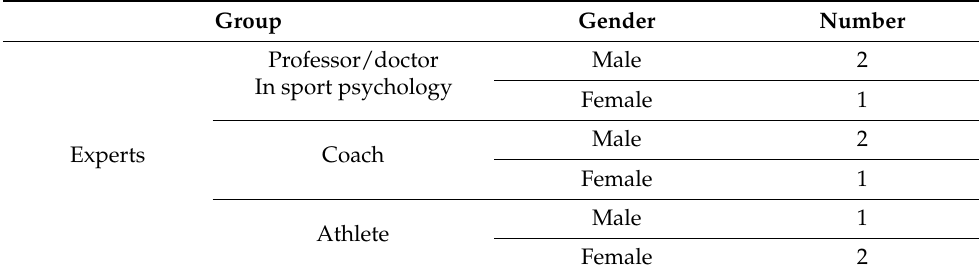
Table 1. General characteristics of the expert group.